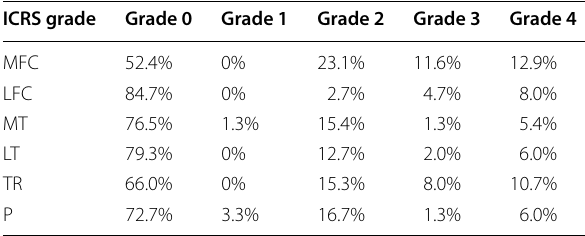
Table 2 The rates of ICRS classification in 6 recipient sites